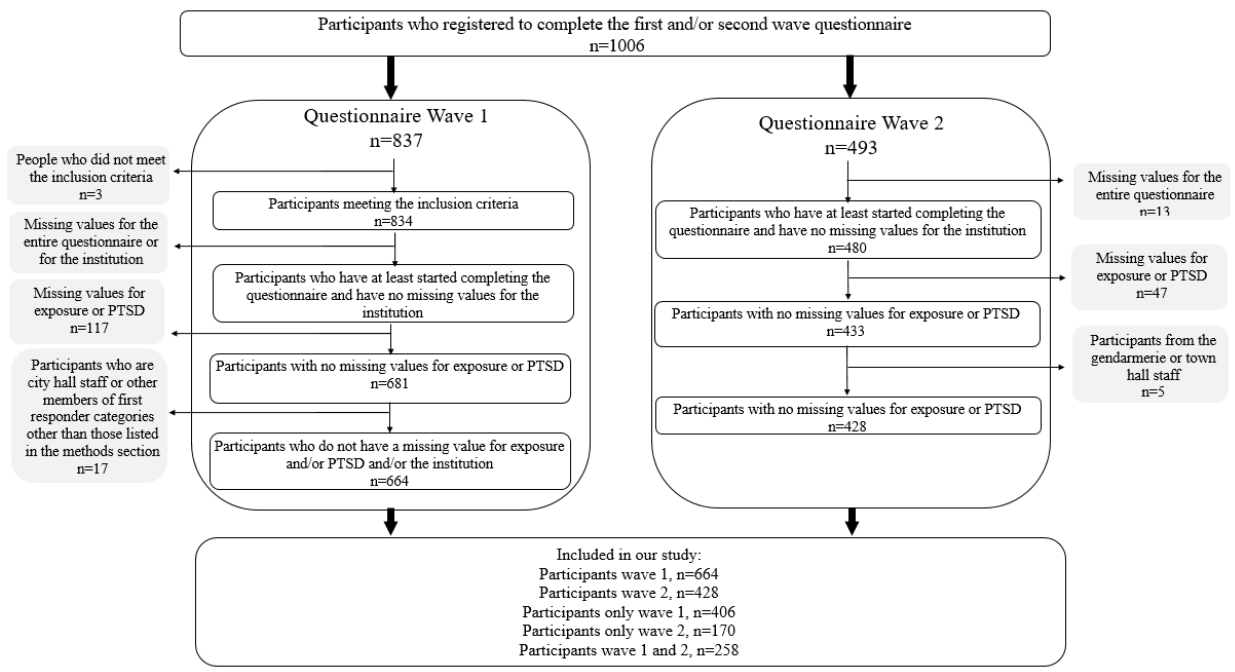
Figure 1. Flowchart, ESPA 13 November survey